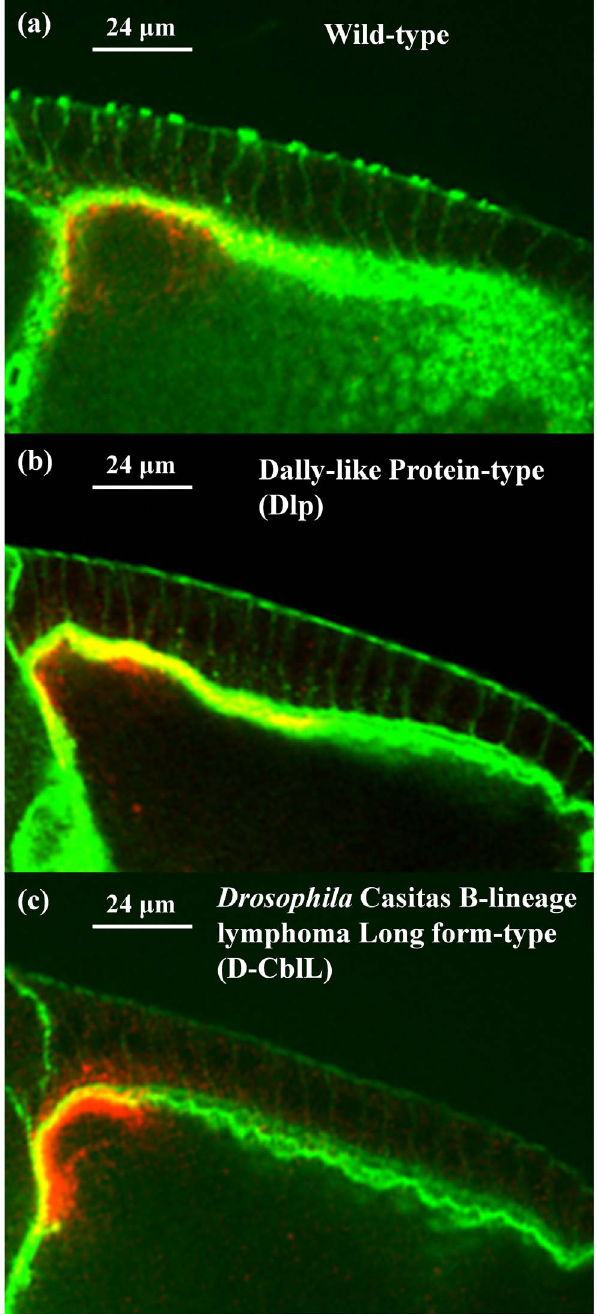
Figure 1. The partial distribution of the Gurken gradient in stage 10A egg chambers for (a) wild-type, (b) overexpressing Dlp, and (c) overexpressing D-CblL. The scale bars both are 24 m m in Figs. 1 (a), (b) and (c).